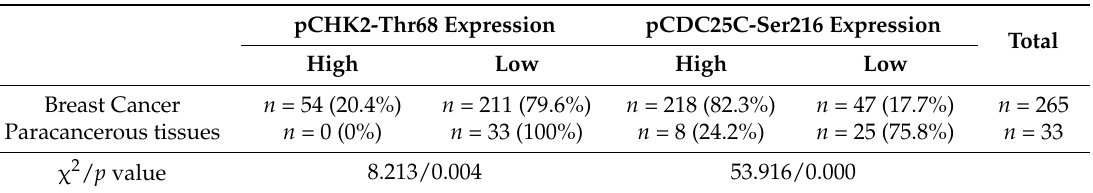
Table 1. Expression of pCHK2-Thr68 and pCDC25C-Ser216 in positively staining breast cancer and paracancerous tissues.